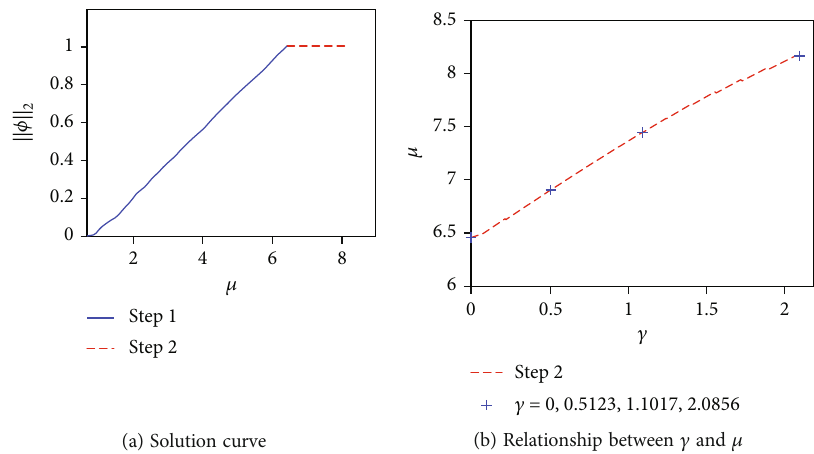
ffiffiffi p 5 , n =